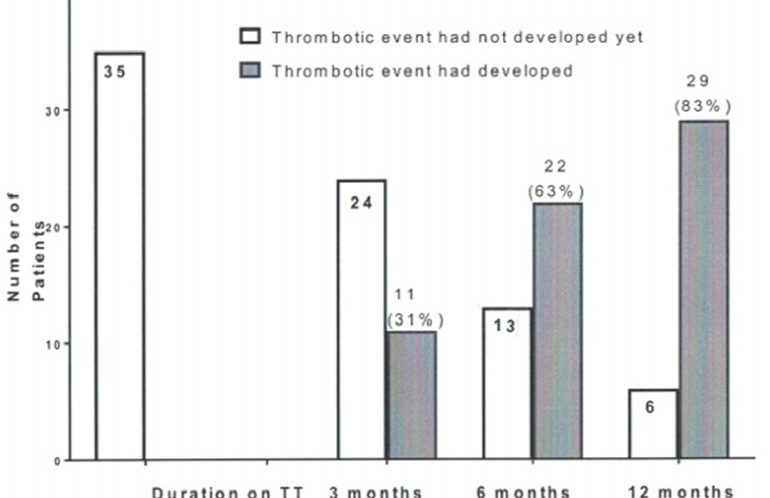
Figure 2. Depletion from the group of 35 thrombophilic patients (Factor V Leiden heterozygosity and/or the lupus anticoagulant) susceptible to developing a thrombotic event 3, 6, and 12 months after starting testosterone therapy.